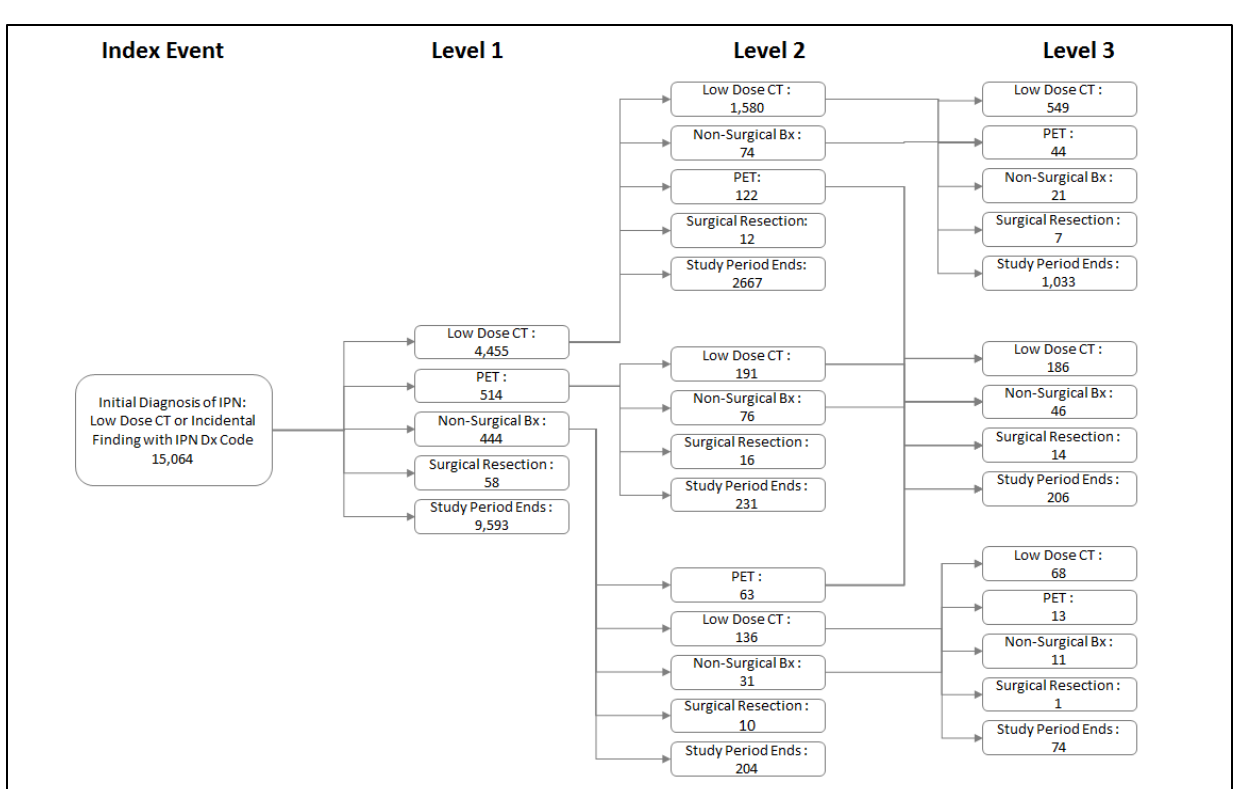
Figure 1. Path of IPN Population through Three Levels of Workup. Numbers Reflect Patient